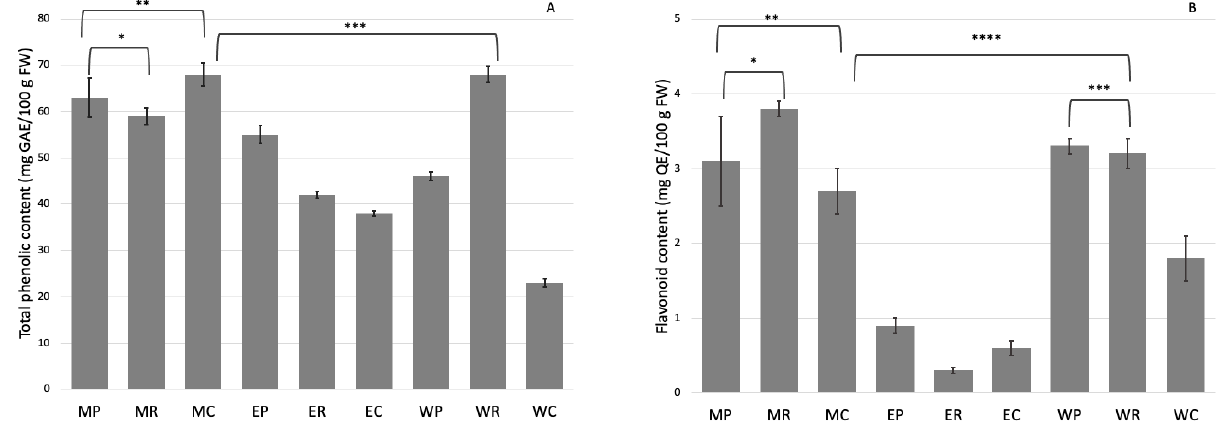
Figure 2. The total polyphenolic content ( A ) and flavonoid content ( B ) determined in A. radiata samples. Asterisk (*) indicates no significant differences between samples ( p > 0.05; one-way ANOVA